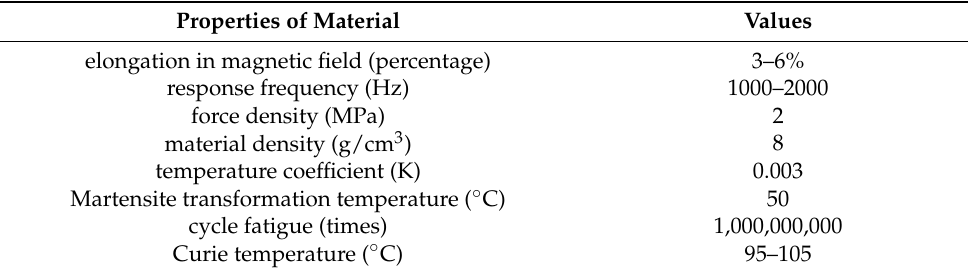
Table 1. Properties of Ni 2 MnGa.